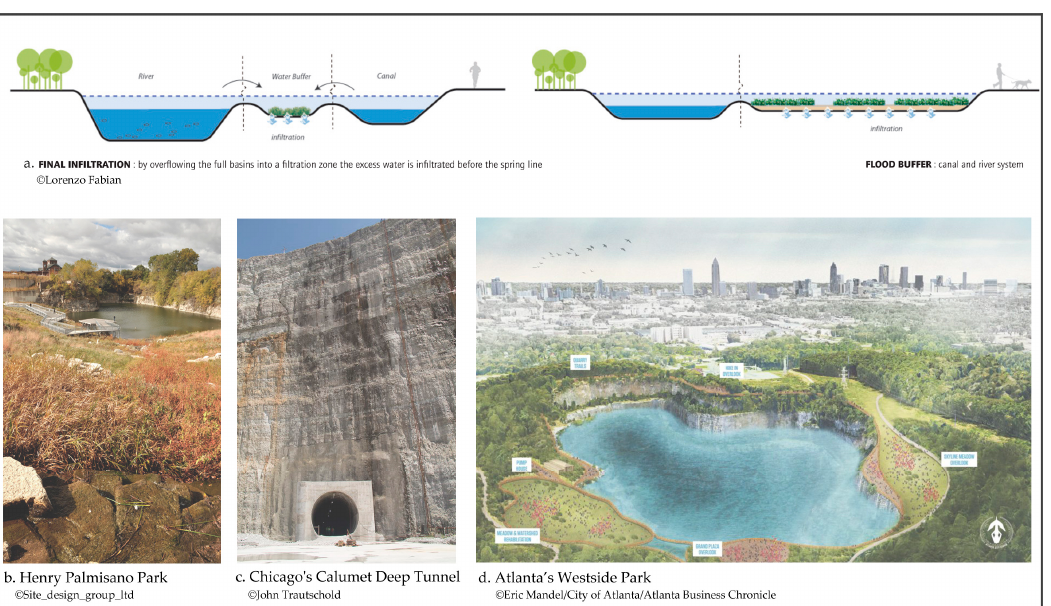
Figure 8. Selected projects related to environmental control.